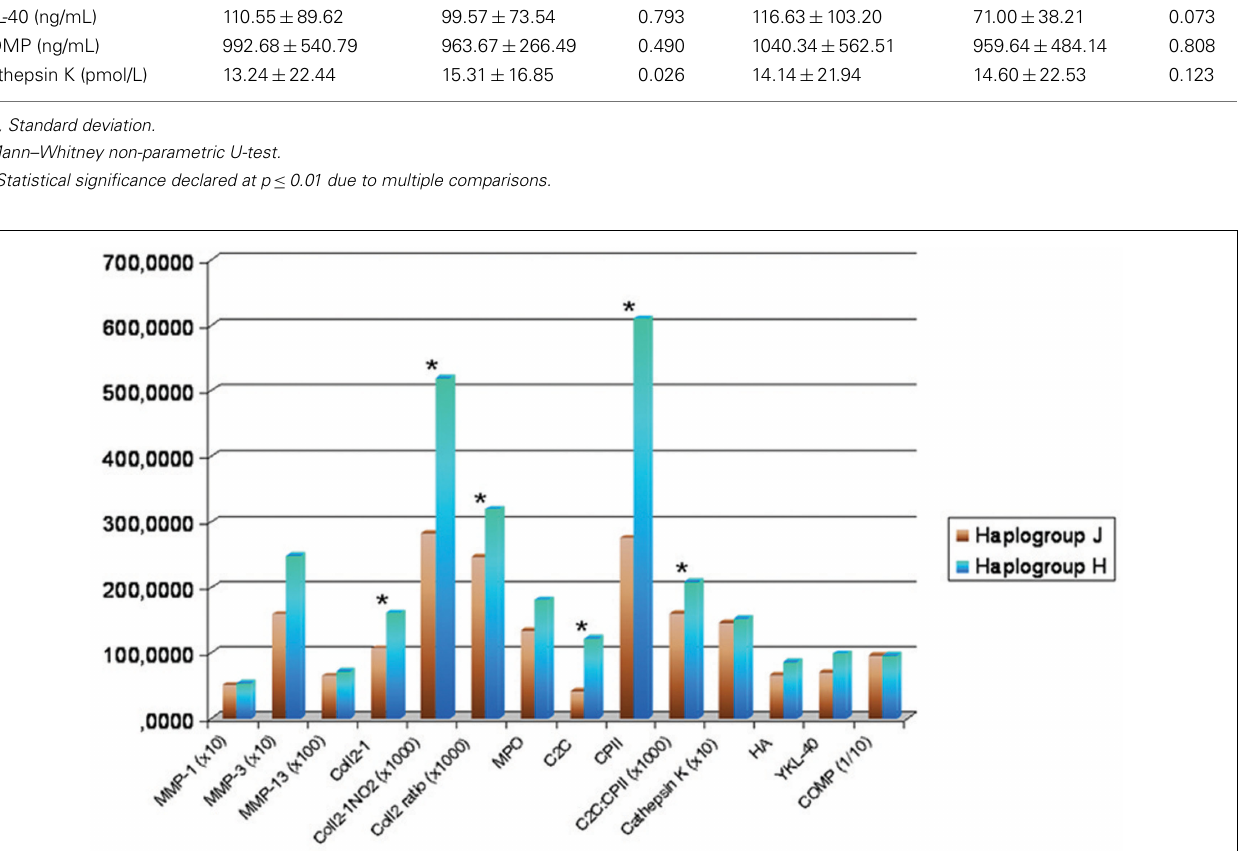
FIGURE 1 | Mean serum levels of osteoarthritis (OA)-related molecular markers in OA patients carrying haplogroup H and OA patients carrying the haplogroup J. (* p ≤ 0.01); MMP, matrix metalloproteinase; MPO, myeloperoxidase; Coll2-1, denaturation epitope of the triple helical domain of